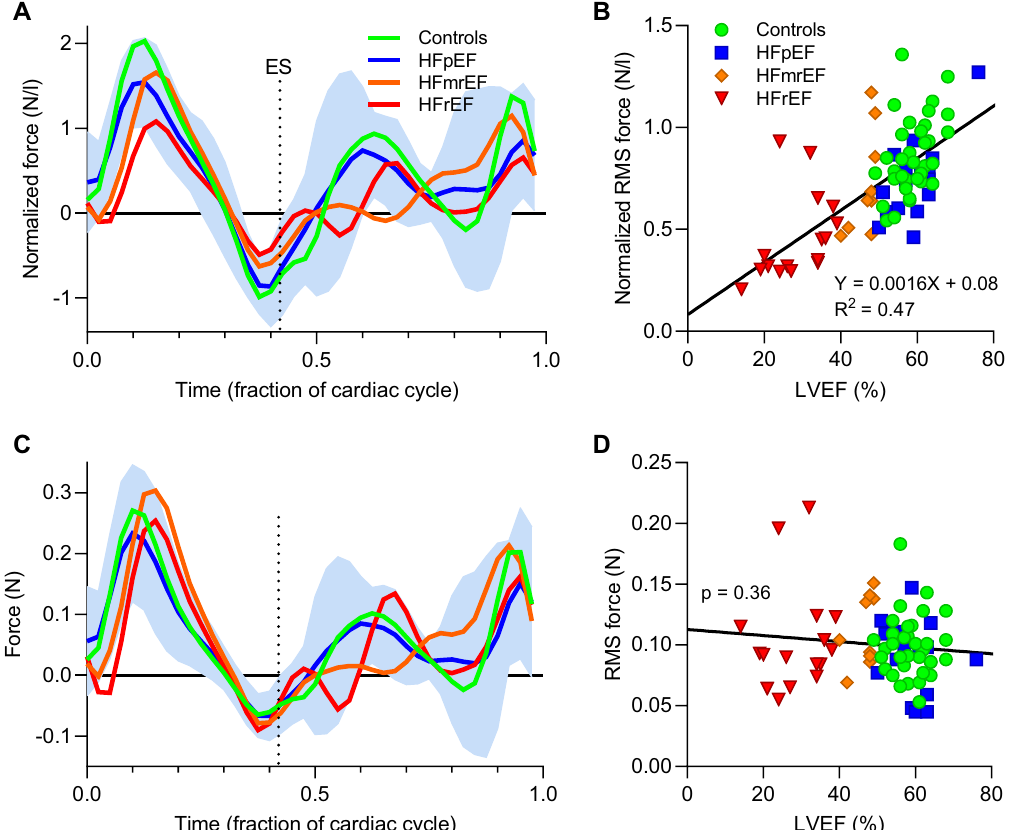
Figure 3. ( A ) Hemodynamic forces in the apical-basal direction, normalized to left ventricular volume, group averages. The light blue shaded area denotes ± 1SD from average values for the HFpEF group. ( B ) Linear regression analysis for EF and volume normalized F RMS for the entire heartbeat demonstrated a strong correlation (p < 0.001). ( C ) Hemodynamic forces without volume normalization, group averages. ( D ) Regression analysis of EF vs F RMS without volume normalization found no significant